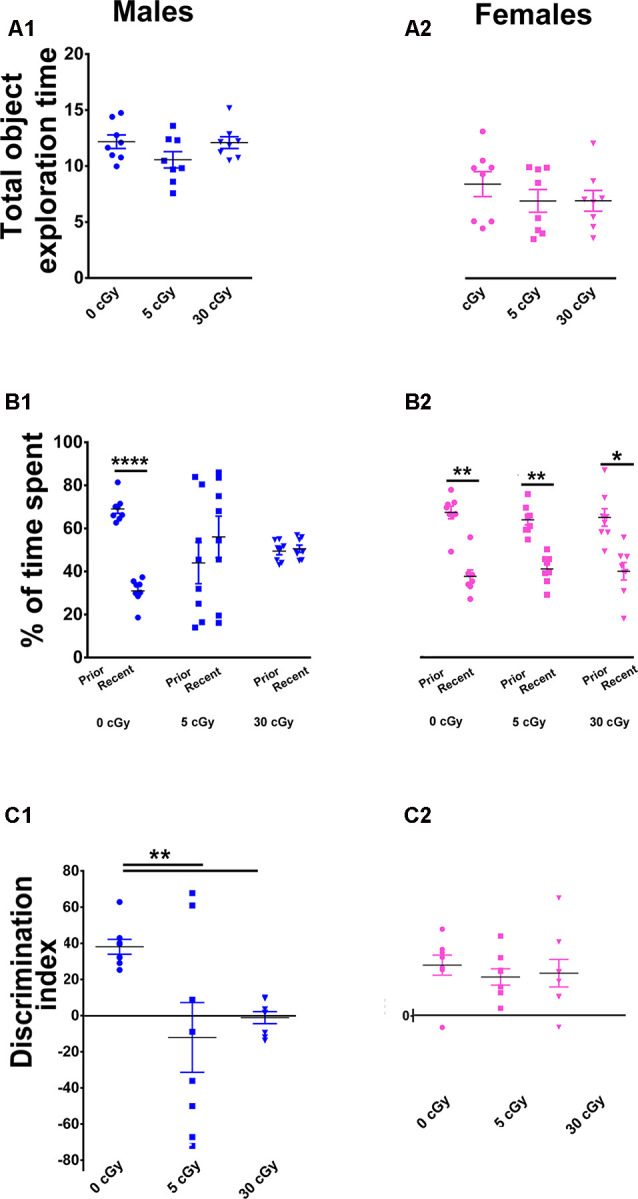
Irradiation with 4He ions causes deficits in recency memory in male but not female mice. Irradiation had no effect on total exploration time during the Temporal Order (TO) task (A1,A2). In male mice, preference for novelty was reduced significantly following irradiation (B1), while in female mice, no change was found (B2). Two-way ANOVA revealed a significant sex × radiation interaction (p = 0.05), a significant radiation effect (p = 0.008), and a significant sex effect (p = 0.03). Post hoc analysis showed that DI was reduced significantly in male mice following irradiation, but not in female mice (C1,C2). In contrast to males, irradiated female mice showed intact recency memory. Individual animals represented as dots; lines depict group means and SEM. N = 8 for each experimental group. *p < 0.05, **p < 0.01, ****p < 0.0001.